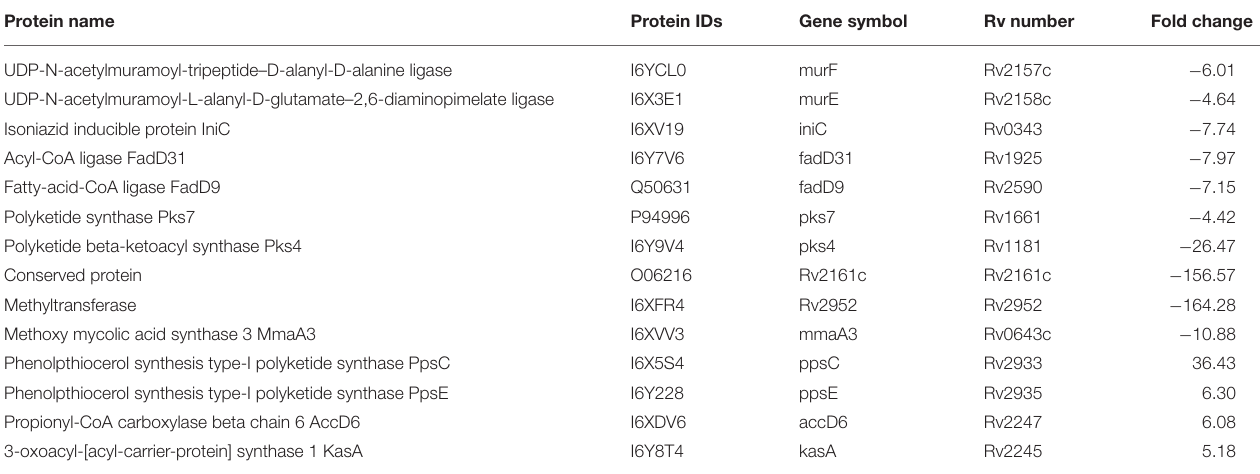
TABLE 6 | List of the differentially abundant proteins involved in cell wall/lipid biosynthesis in M. tuberculosis lineage 7 (L7-35 and L7-28) vs. lineage 4 (H37Rv) strains. Protein